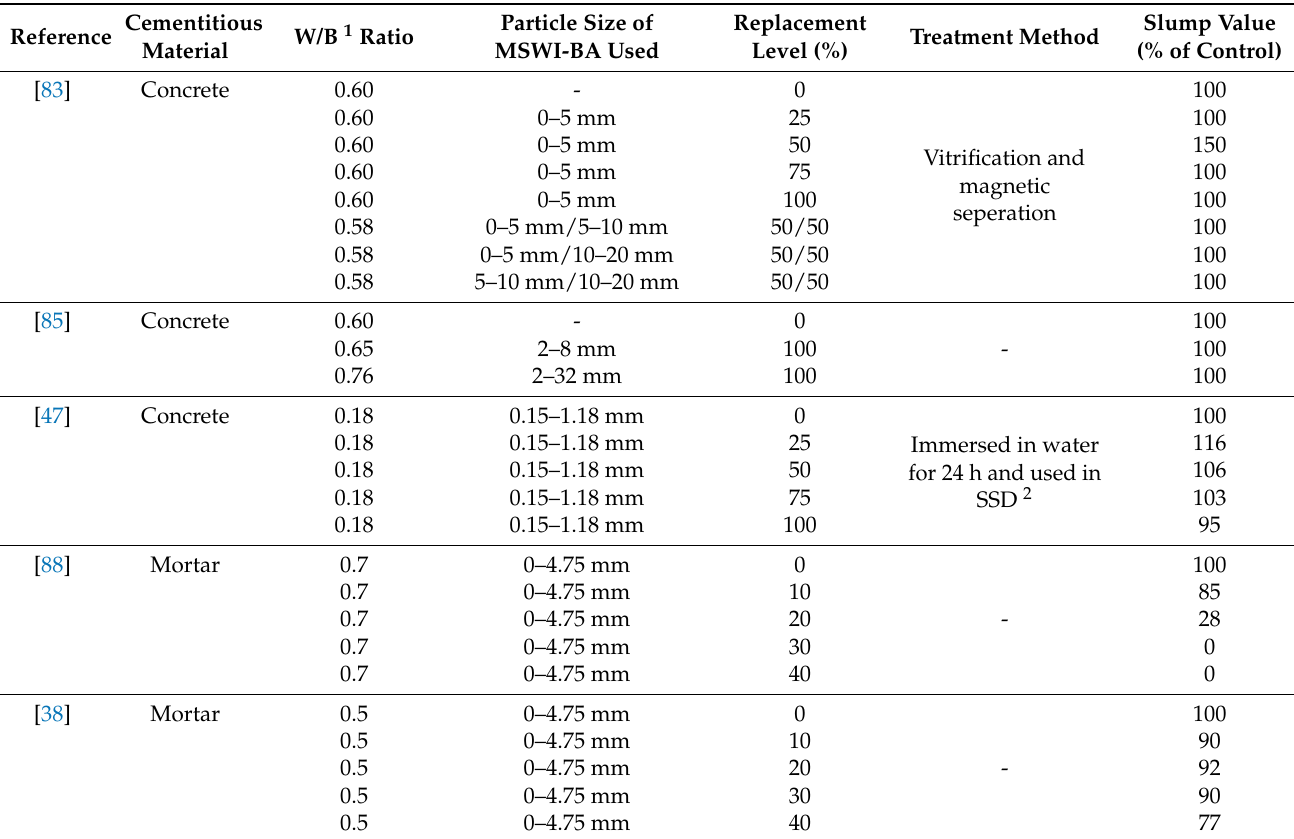
Table 4. Slump value of cementitious materials containing